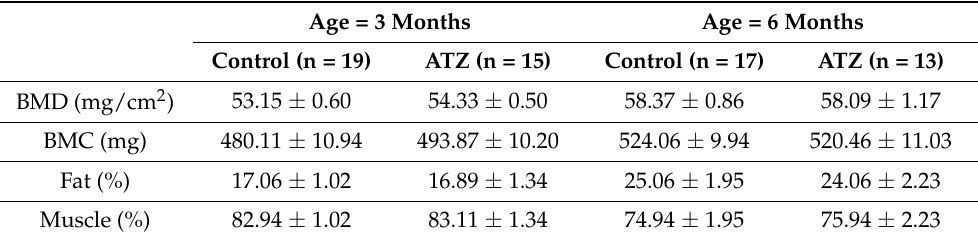
Table 3. The effect of atrazine on muscle, bone and fat properties at 3 and 6 months of age in the F1. Bone mineral density (BMD) values were multiplied by 10 4 to reflect (mg/cm 2 ). Bone mineral content (BMC) values were multiplied by 10 4 to reflect milligrams (mg). No significant differences were found between the control and ATZ treatment for all parameters. Data are mean ± SEM, with >7 L per treatment, per age cohort.